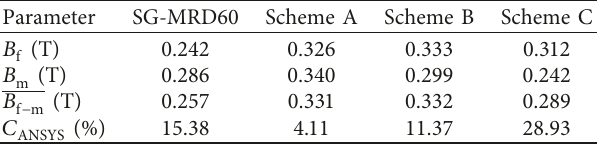
Table 6: Magnetic flux density result obtained by FEA.